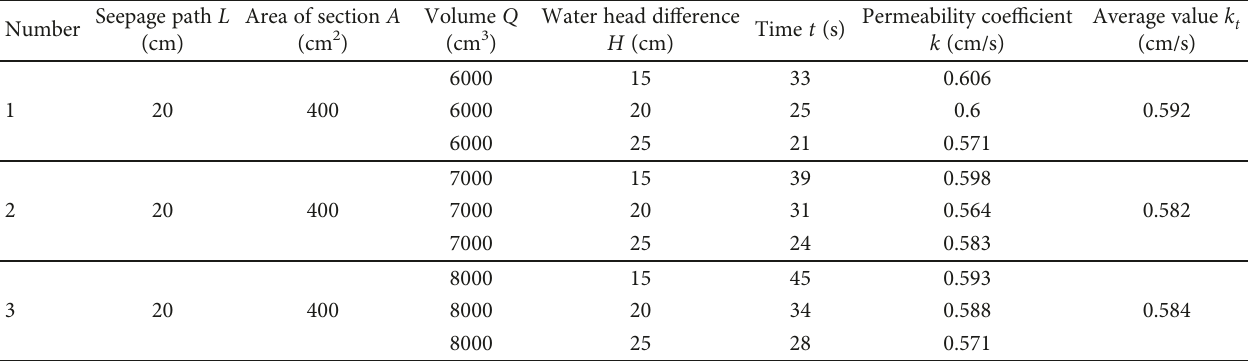
Table 2: Results of the penetration test for a fractured rock mass ( ξ = 0 9 ).